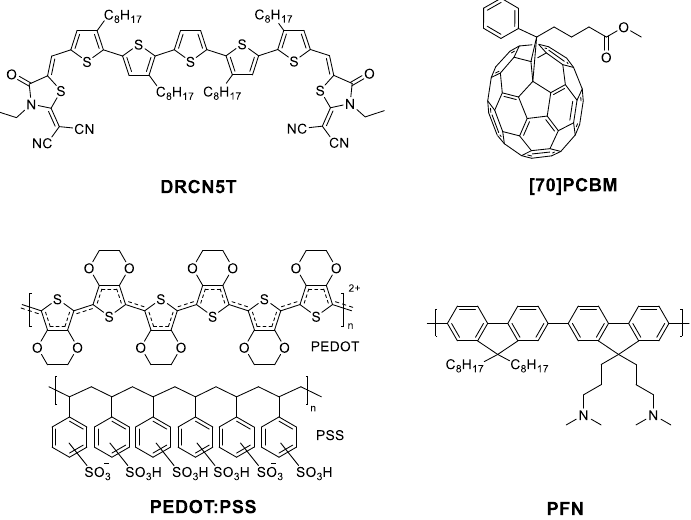
Figure 1. Chemical structures of the used materials in this work.